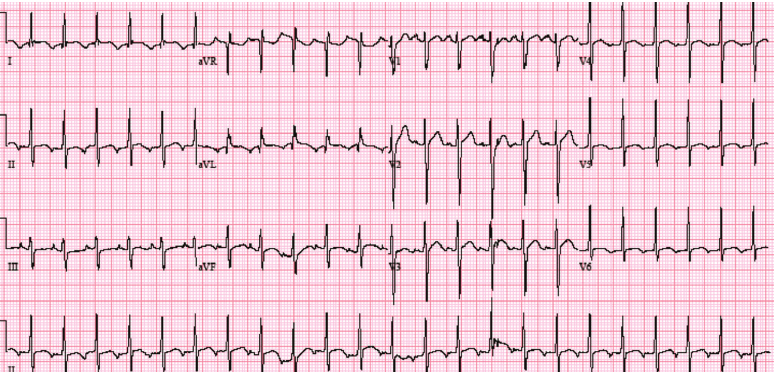
Figure 1: 12 lead ECG on presentation. Narrow complex tachycardia with HR of 139 and nonspecific T wave abnormalities.